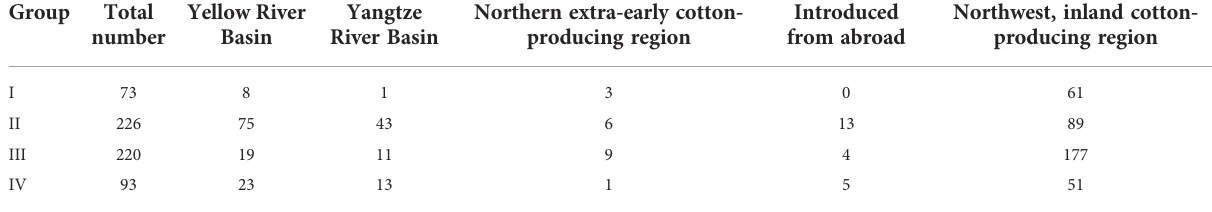
TABLE 2 Distribution of accessions from fi ve sources among the four groups. Group